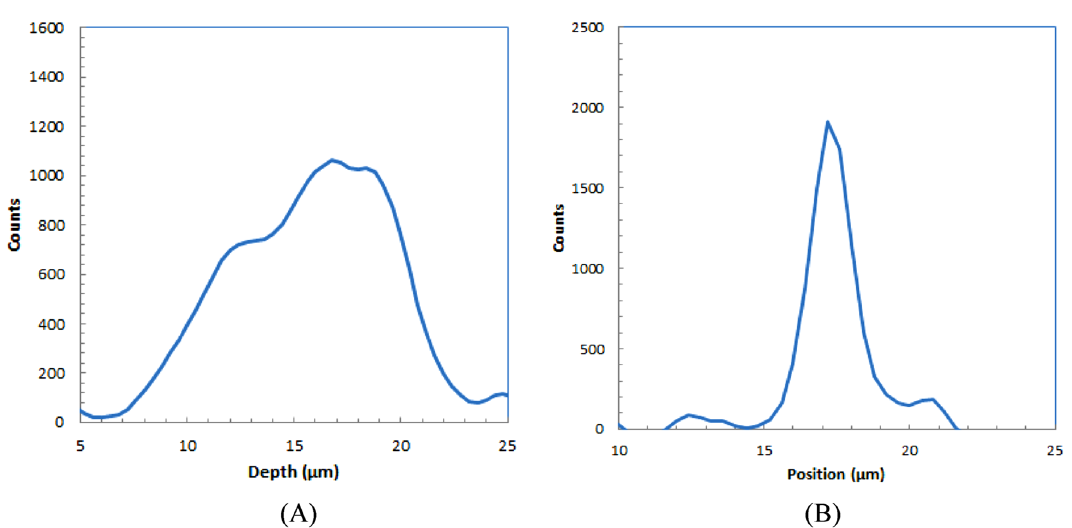
Figure 6. Image of alpha particles in the GAGG plate measured by the developed system for HE alpha source ( A ) and magnified image ( B ) of the area in the square.